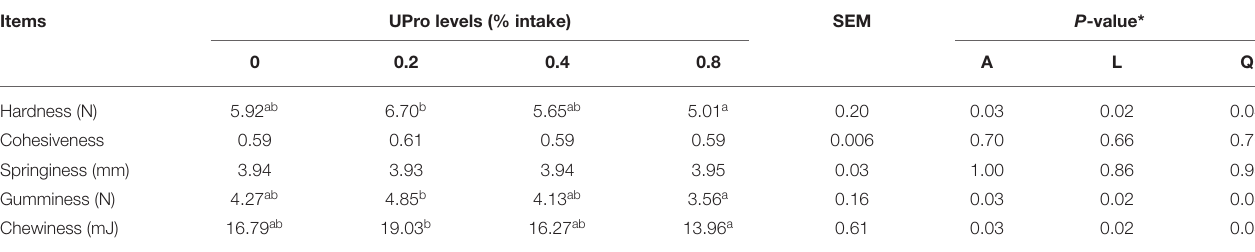
TABLE 6 | Effect of dietary UPro on protein gel properties.